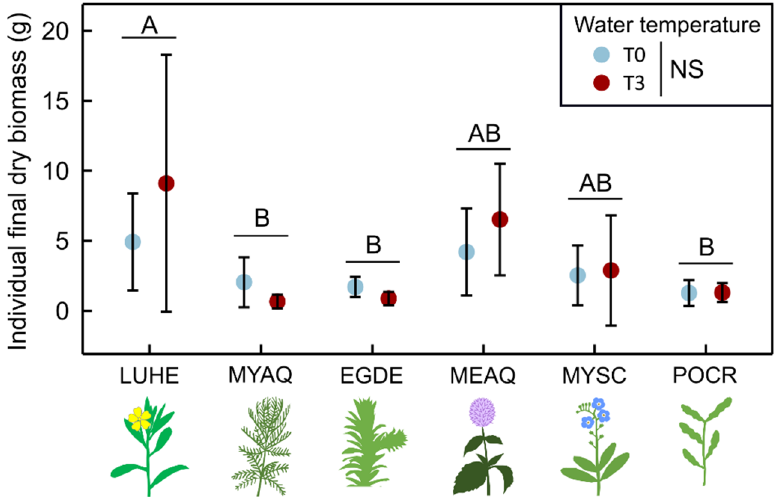
Figure 3. Individual dry biomass (mean ± 95% CI) after 20 weeks of exposure to ambient water temperature (T0) or to a 3 °C warming (T3) for Ludwigia hexapetala (LUHE), Mentha aquatica (MEAQ), Myriophyllum aquaticum (MYAQ), Myosotis scorpioides (MYSC), Egeria densa (EGDE) and Potamogeton crispus (POCR). Capital letters indicate difference among species. NS = Not Significant (Two-way ANOVA, n = 5).